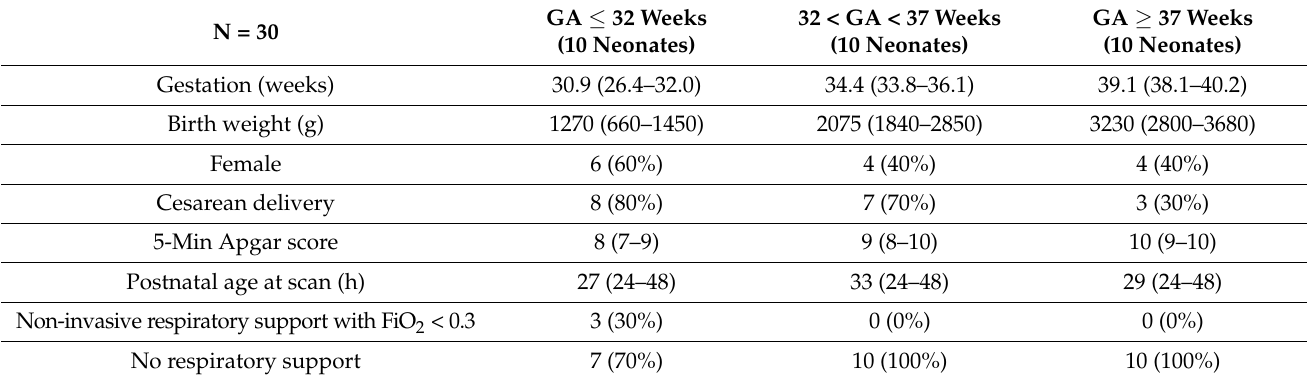
Table 1. Clinical characteristics of the first cohort of